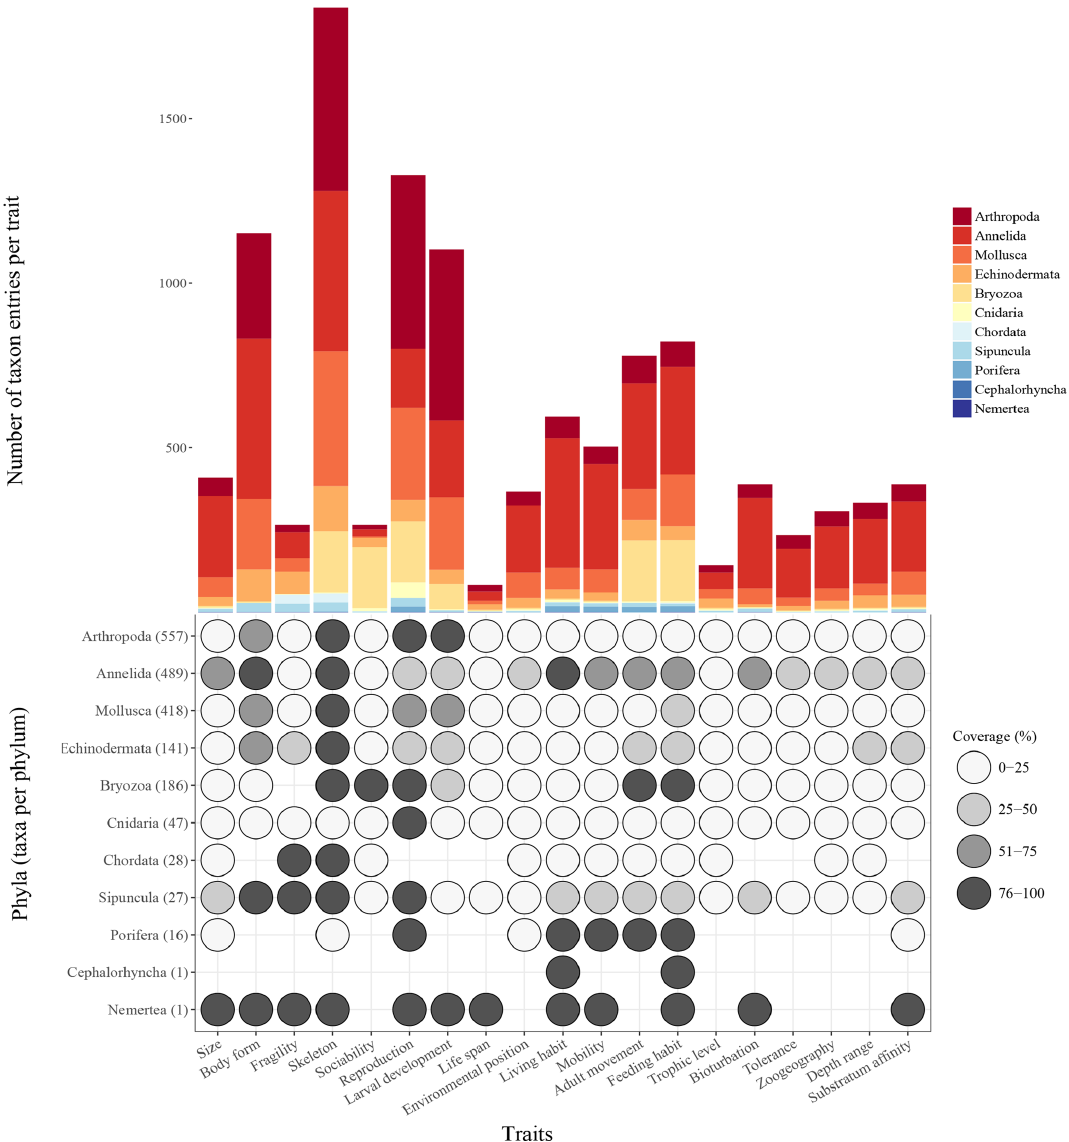
Figure 7. Scheme visualizing the taxon entries per trait (bar chart), the number of taxa per phylum (brackets) and the data coverage per trait per phylum (dot